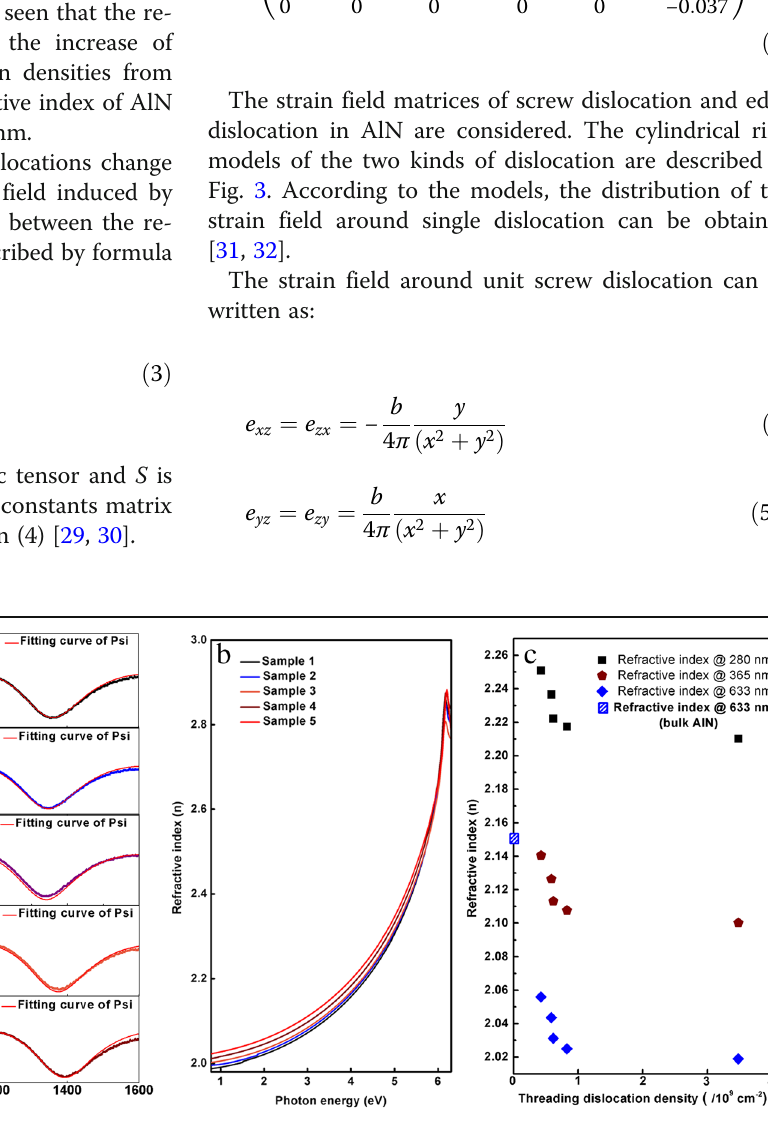
Fig. 2 a Partial experimental data of SE measurement and fitting curves. b The refractive index curve. c Refractive index vs. different TDDs at 280 nm, 365 nm, and 633